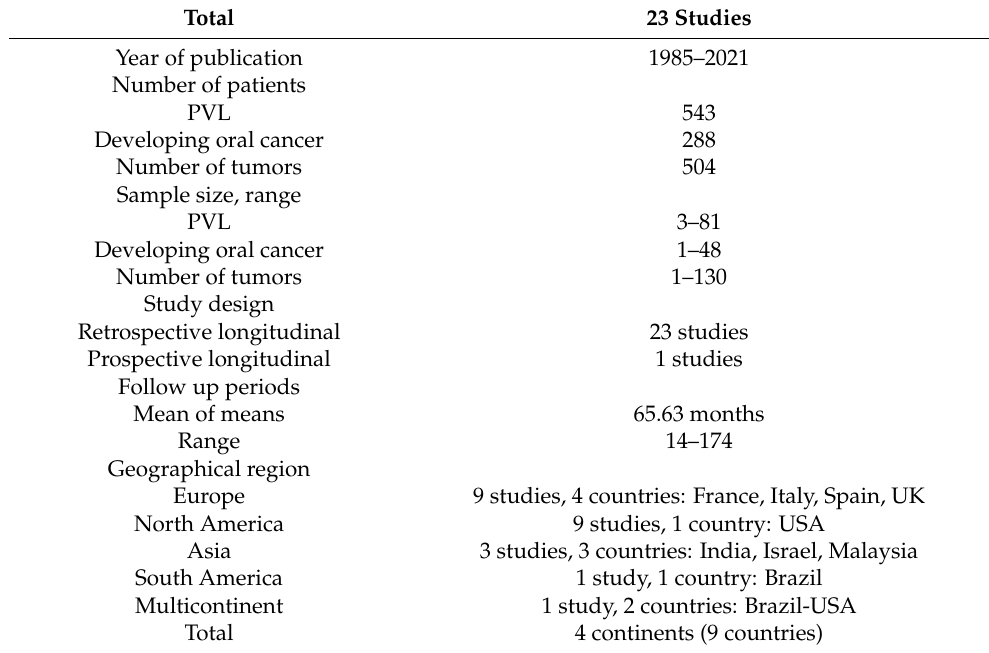
Table 1. Summarized characteristics of reviewed studies.